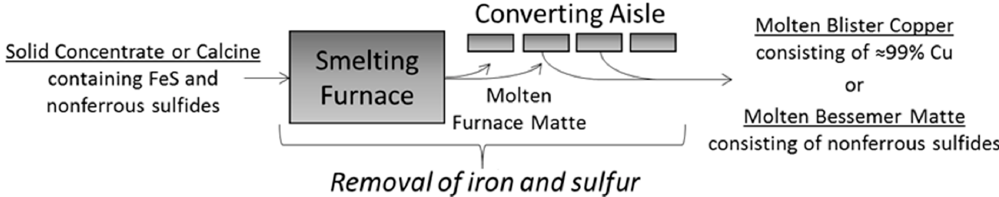
Figure 3. Schematic of conventional copper or nickel–copper sulfide smelter operations. The smelting furnace and converting aisle eliminate iron and sulfur, producing blister copper in the case of copper smelters and Bessemer matte in the case of nickel–copper